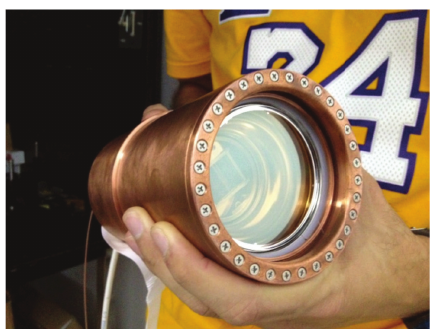
Figure 9: NEXT-100 vessel in the final stages of the production. Main body of the vessel (a) and endcap with the port to extract the different signals and circulate the gas (b).